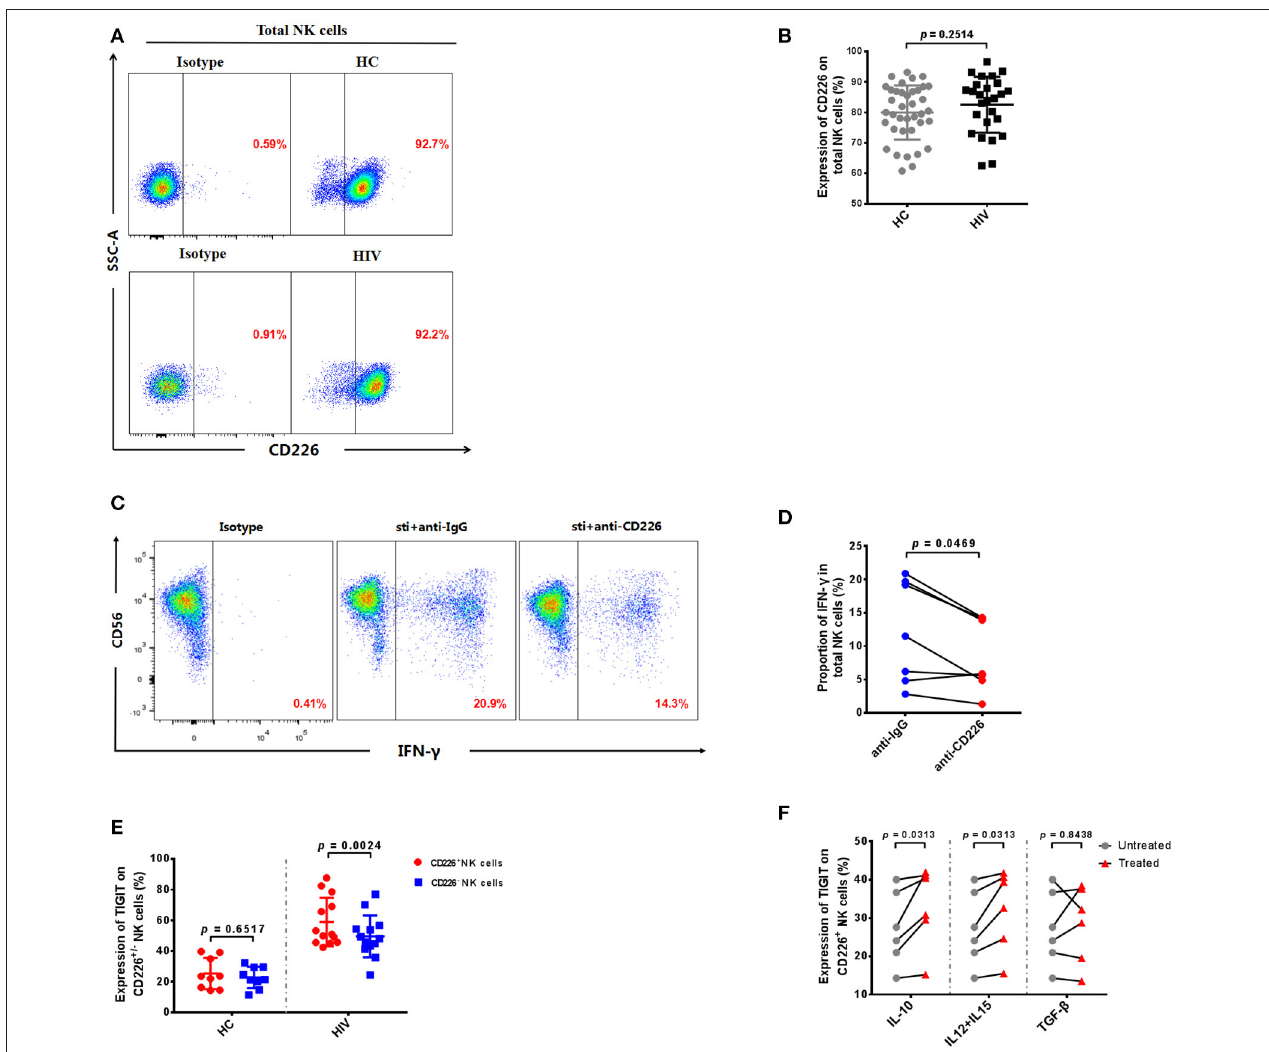
FIGURE 4 | TIGIT is primarily expressed on CD226 + NK cells in HIV-infected individuals. (A) A representative flow cytometry plot showing the expression of CD226 on total NK cells in HIV-infected and HC individuals. (B) Comparison of the percentages of CD226 + NK cells in HIV-infected ( n = 26) and HC ( n = 38) groups. (C) A representative flow cytometry plot showing the proportion of IFN- γ producing NK cells after treatment with 20 µ g/mL anti-human CD226 antibodies or purified mouse IgG (as a negative control) from HIV-infected individuals. The expression of IFN- γ was gated according to an isotype control. (D) Paired comparisons of the proportion of IFN- γ producing NK cells from HIV-infected individuals ( n = 8) after treatment with 20 µ g/mL anti-human CD155 antibodies or purified anti-mouse IgG (as a negative control). (E) Comparison of TIGIT expression on CD226 + NK cells in the HIV ( n = 13) and HC ( n = 9) groups. (F) Paired comparisons of the expression of TIGIT on CD226 + NK cells unstimulated or stimulated with rIL-10, rIL-12 + rIL-15, or rTGF- β . A Mann-Whitney U test was used for comparisons between two groups. A Wilcoxon matched-pairs signed-rank test was used for paired-group comparisons. p < 0.05 was considered